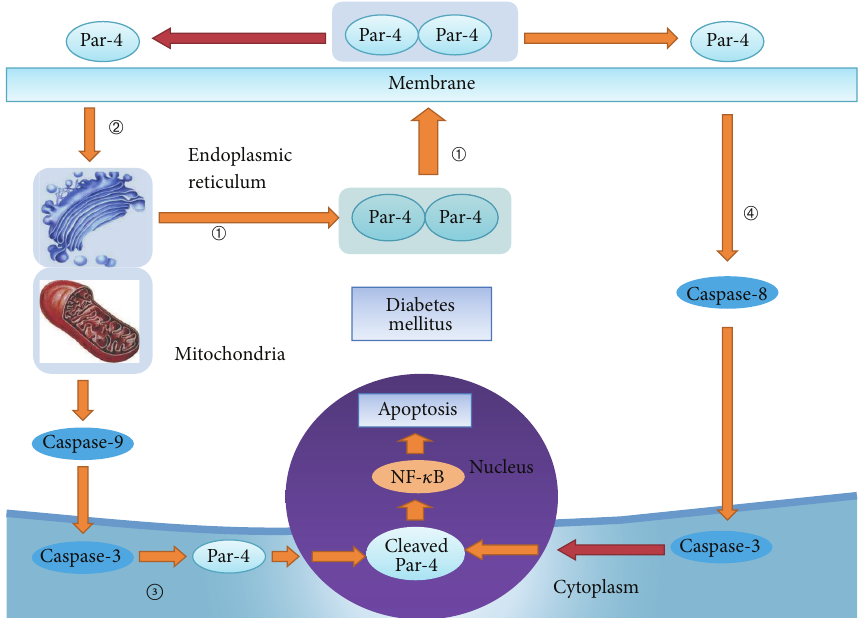
Figure 7: ER stress and mitochondrial dysfunction prompts Par-4/NF- 𝜅 B expression in the nucleus, increasing apoptosis of islet 𝛽 cells after the high glucose/palmitate intervention. A ER stress promotes the secretion of Par-4; B the secretion of Par-4 increases ER stress; C mitochondrial dysfunction drives the translocation of Par-4 into the nucleus and induces cell apoptosis; D Par-4 translocates into the nucleus and induces cell apoptosis via the cell membrane